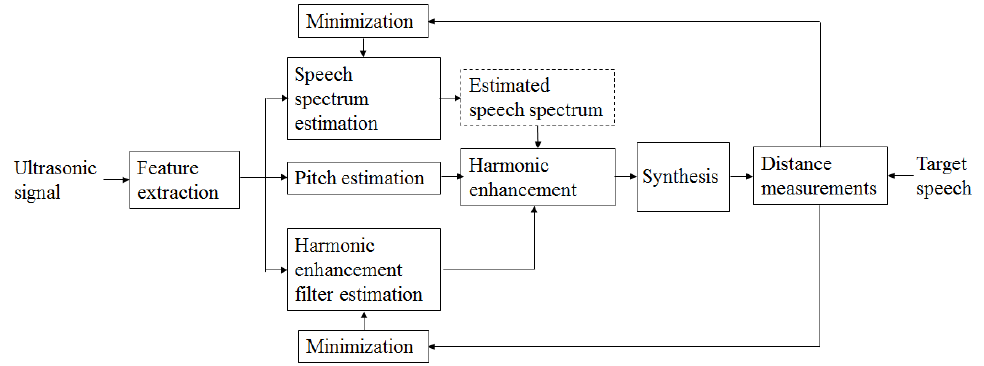
Figure 3. Block diagram of the proposed ultrasonic SSI